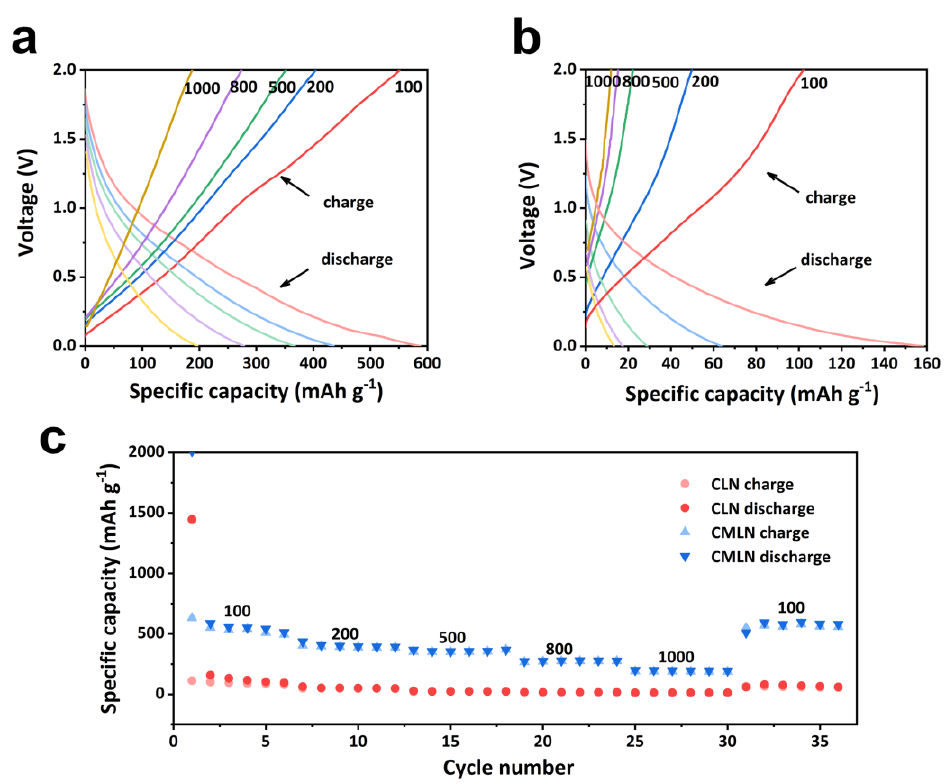
Figure 5. ( a ) Charge/discharge curves of CMLN at different current densities; ( b ) charge/discharge curves of CLN at different current densities; ( c ) the rate performance of CLN and CMLN with different current densities.